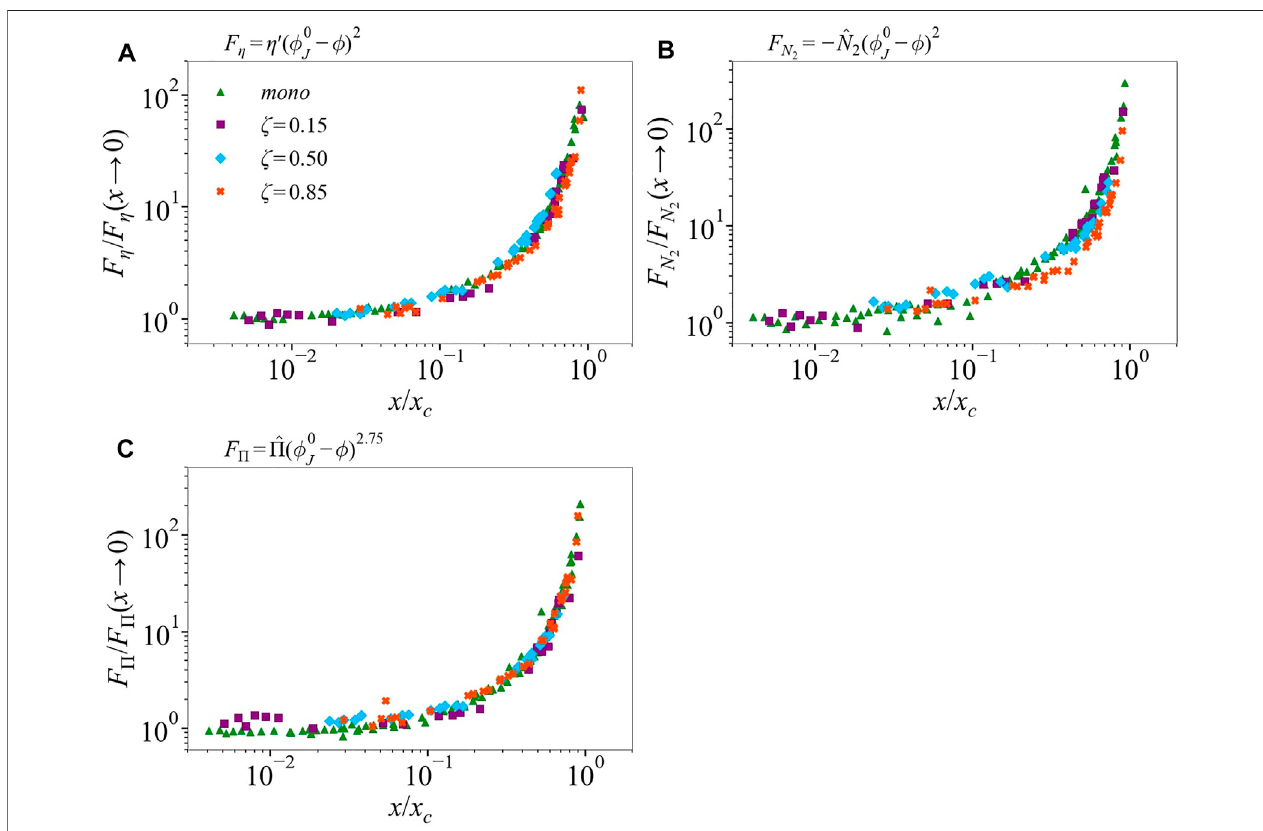
FIGURE8| Scalingfunctions (A) F η , (B) F N ,and (C) F Π ,normalized bytheirbaseline values,versusthescaling variable x / x c forsimulatedmonodisperse ( δ =1.4 2 and ζ = 0.50 over 0.52 ≤ ϕ ≤ 0.63) and bidisperse ( δ = 3 for ζ = 0.15, 0.50, 0.85 over 0.54 ≤ ϕ ≤ 0.60) suspensions, where x (cid:1) f / ( ϕ 0 J − ϕ ) and x c (cid:1) 1/ ( ϕ 0 J − ϕ μ J ) . For monodispersesuspensionandbidispersesuspensionat ζ =0.15theformof f is f ( σ ) (cid:1) e − σ */ σ .Forbidispersesuspensionsat ζ =0.50and0.85itis f fi t .Thelegendinpanel (A) is used in all